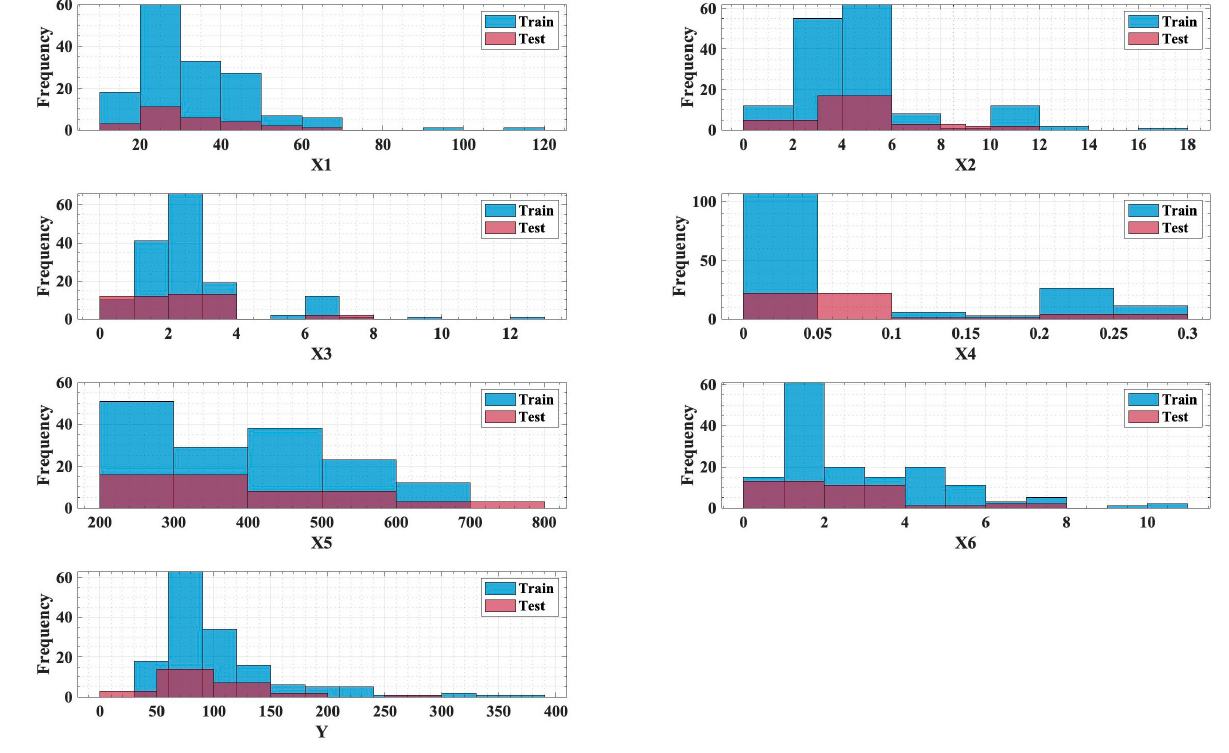
Figure 4. The histogram of the database.